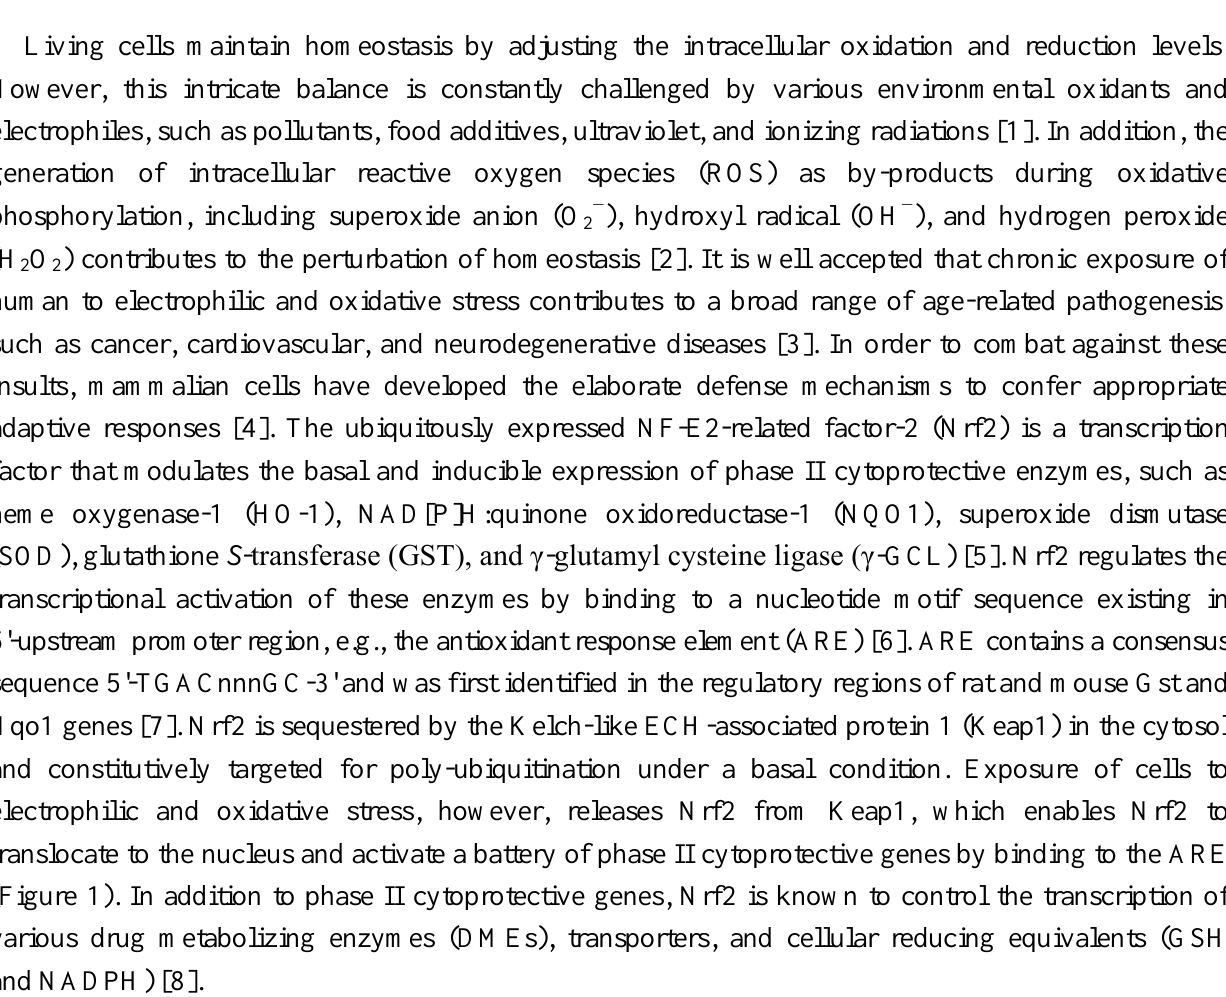
Figure 1. Regulation of ARE-dependent Gene Expression by Keap1 and